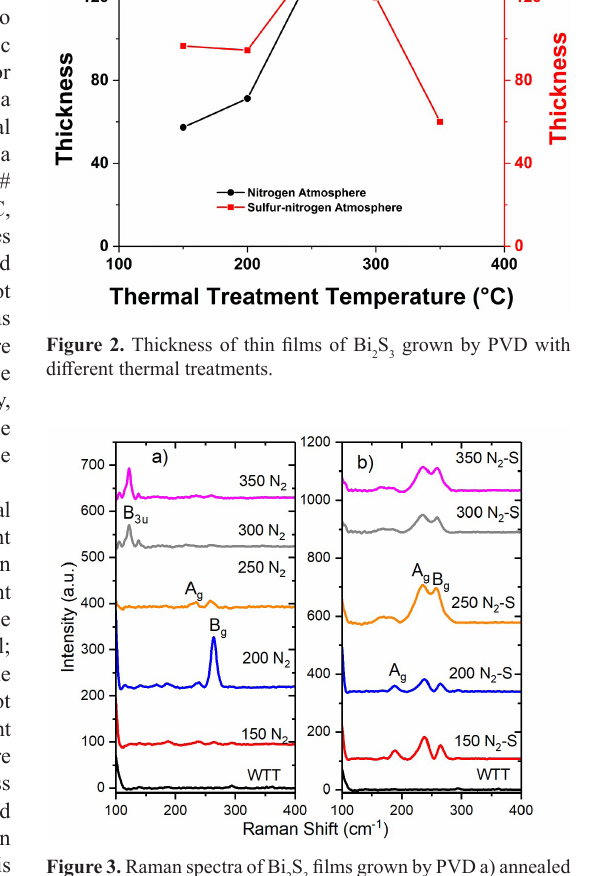
Figure 3. Raman spectra of Bi in a nitrogen atmosphere and b) annealed in a nitrogen-sulfur atmosphere,